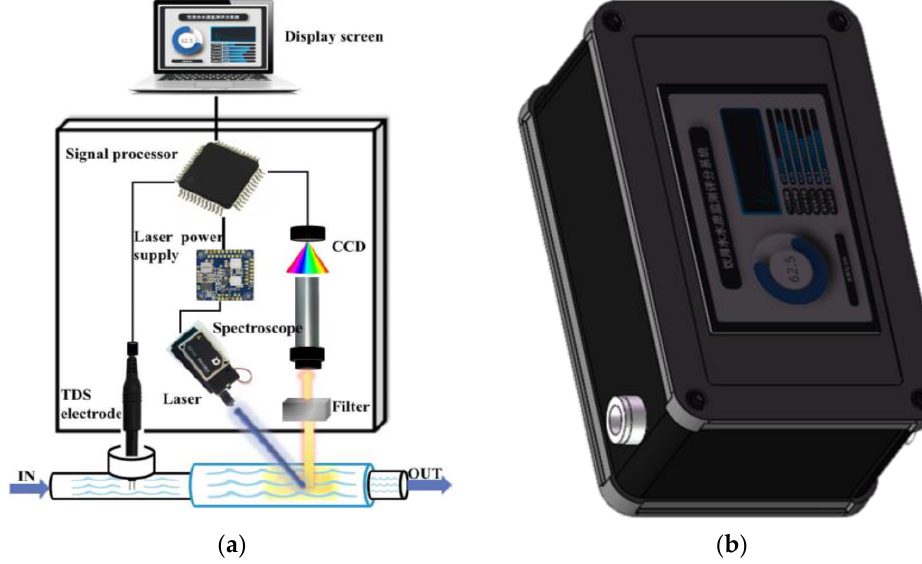
Figure 1. Composition and outline of the small drinking water quality instrument. ( a ) Structure schematic of the detecting instrument; ( b ) Outline picture of the detecting instrument.